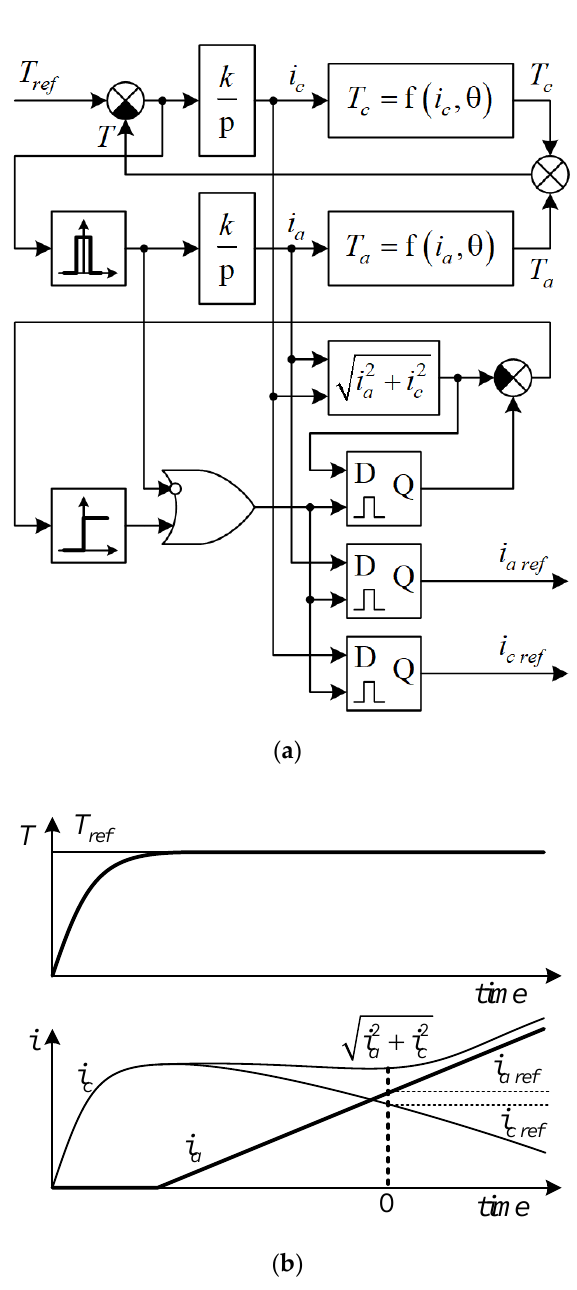
Figure 5. Evaluation of the current references for the given torque command: ( a ) block diagram, ( b ) transient during optimal reference evaluation.